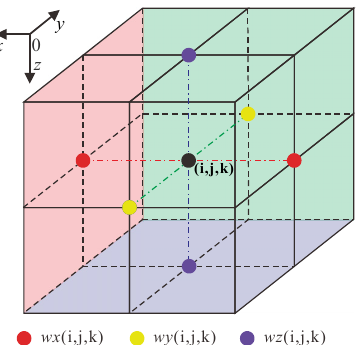
Figure 1. Schematic of one cube applied in IFDM. wx , wy , and wz are the coefficients of one cube in the x , y and z directions, respectively.